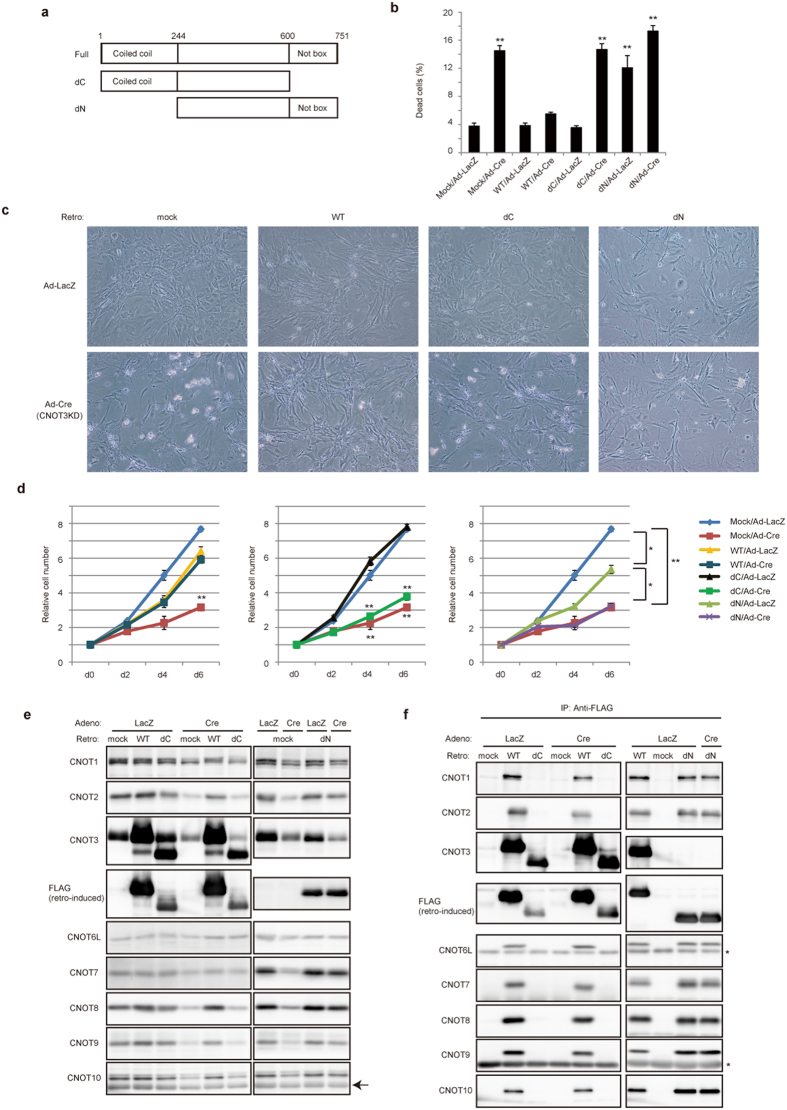
Activity of the CCR4-NOT complex depends upon a complete CNOT3 C-terminus and CNOT3 function requires an intact N-terminus.(a) Schematic diagram of CNOT3. CNOT3 consists of an N-terminal coiled-coil domain, a linker region and a Not box region that shares homology with CNOT2. Numbers above the protein outline represent amino acid positions at domain boundaries. (b) Cell death assessed by PI uptake using flow cytometry of CNOT3loxP/loxP MEFs transduced with retroviruses (CNOT3 constructs)/adenoviruses (LacZ or Cre). n = 3. (c) Cell morphology 4 days after adenovirus infection. (d) Growth curves corresponding to CNOT3loxP/loxP MEFs transduced with retroviruses (CNOT3 constructs)/adenoviruses (LacZ or Cre). Day 0 corresponds to 2 days after adenovirus infection. Each time point was determined in triplicate. Growth curves of control cells, Mock/LacZ (blue line) and Mock/Cre (red line), are blotted to every graph for comparison. All values represent means ± sem.*P < 0.05; **P < 0.01. (e) Lysates were prepared from cells infected with retroviruses (CNOT3 constructs) and adenoviruses (LacZ or Cre) and analyzed by immunoblot. The arrow indicates a nonspecific signal. (f) Lysates prepared in (e) were immunoprecipitated with anti-FLAG antibody and immunoprecipitates were analyzed by immunoblot. *IgG heavy and light chains.